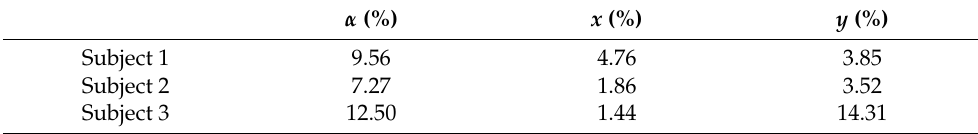
Table 6. The average deviation of the trajectory.